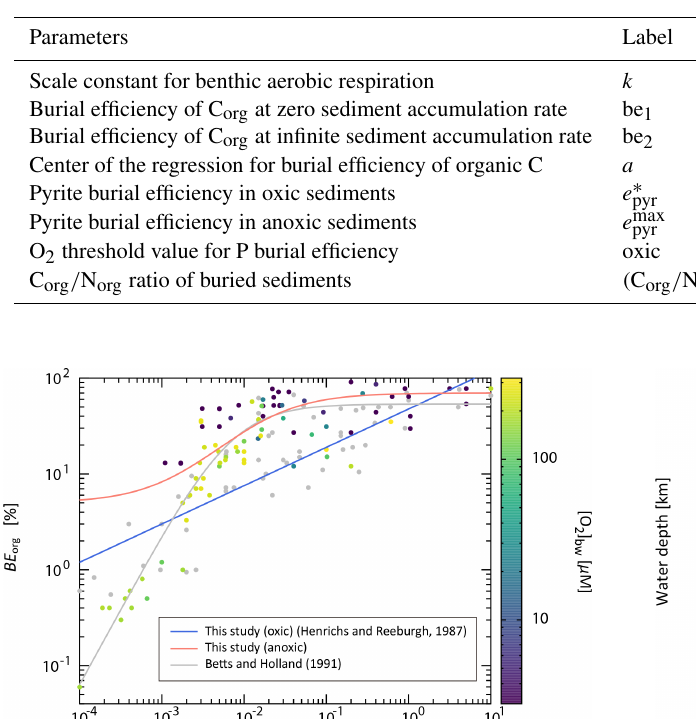
Table 5. Parameters used in the sediment–water interface module of CANOPS-GRB.